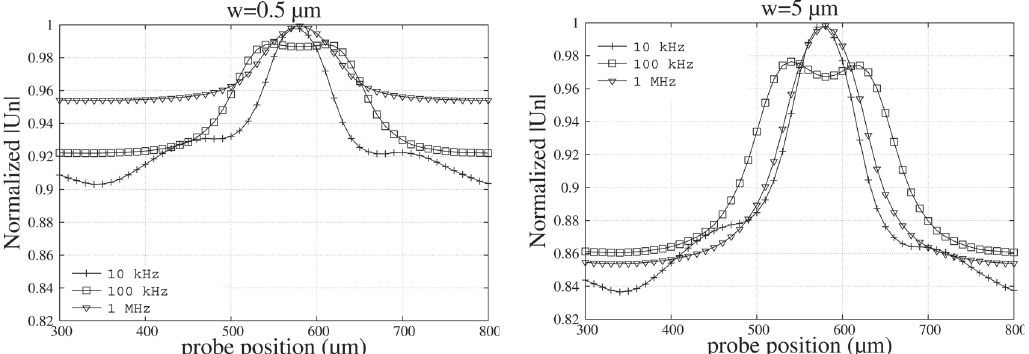
Fig. 3. Normalized thermoelastic displacement